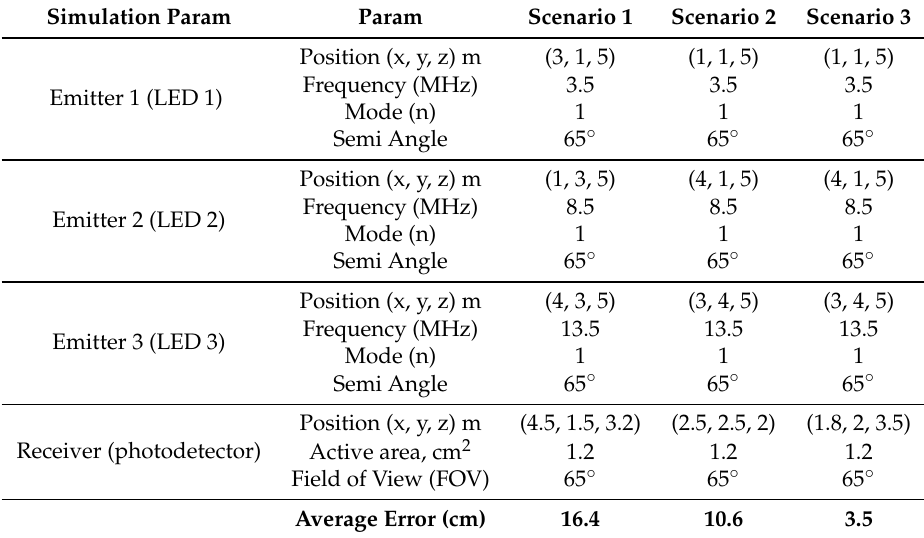
Table 1. System simulation